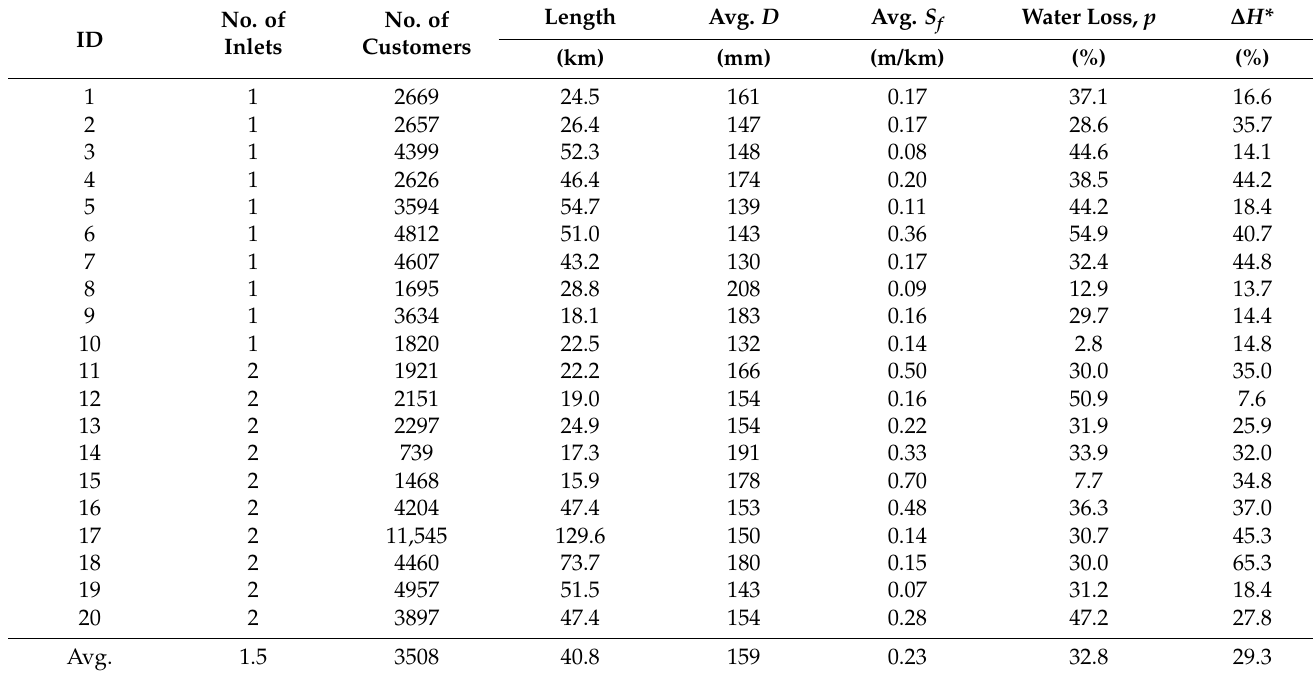
Table 1. Characteristics of district metering